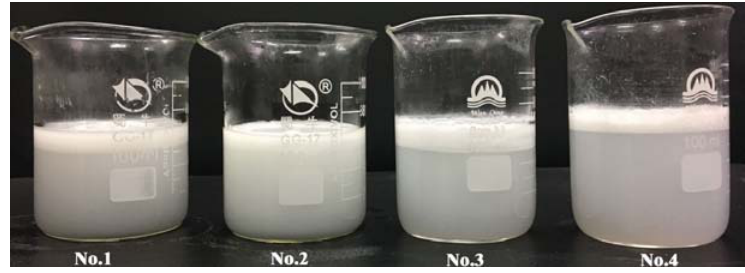
Figure 2. Images of four samples from different mixing ratios of emulsifiers after 2 h standing.